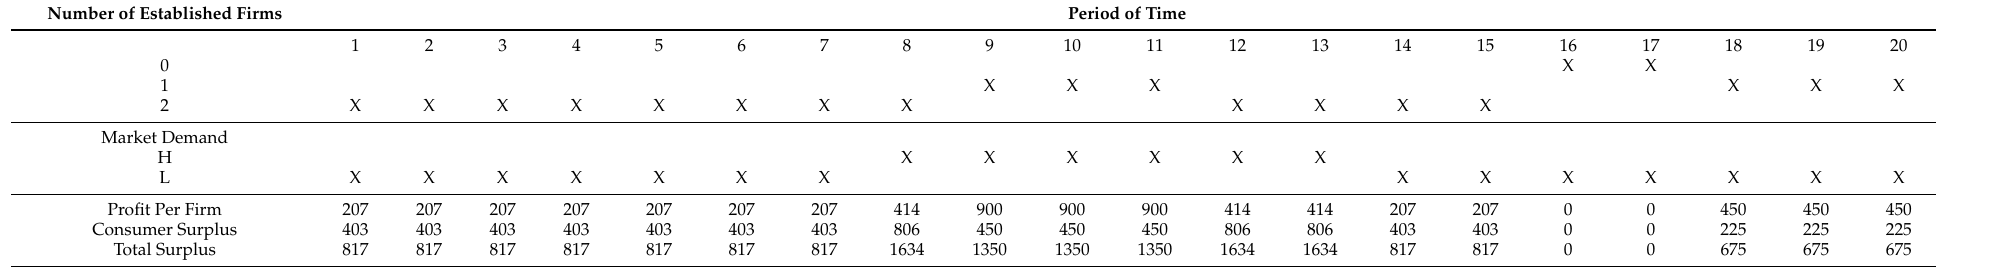
Table 12. Two active firms in the Cournot framework with the initial state of the system ( 2, L )